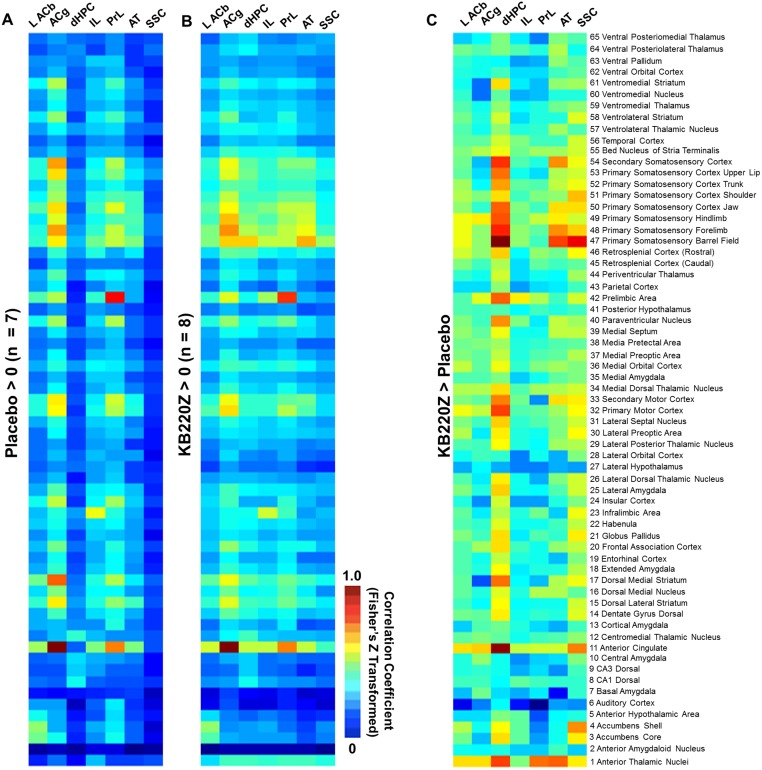
Heat maps of cross-correlation coefficient values (Fisher’s z-transformed) for seed regions and 65 rat brain atlas ROI.(A) Data summary for placebo treatment. (B) Data summary for KB220Z treatment. (C) Difference map of correlation coefficient values greater in KB220Z than placebo. The scale bar color indicates degree of connectivity (cool-blue < warm-yellow < hot-orange/red). Note the overall similar pattern of connectivity within and outside brain reward regions between A and B. The degree of connectivity is strengthened with KB220Z treatment compared to placebo (B vs. A) and is observed in the difference heat map in (C). ROI that correspond to each row in the color-coded maps are shown on the far left. The seed region corresponding to each column are left accumbens (L ACb), anterior cingulate cortex (ACg), dorsal hippocampus (dHPC), infralimbic area (IL), prelimbic area (PrL), anterior thalamus (AT) and somatosensory cortex (SSC).